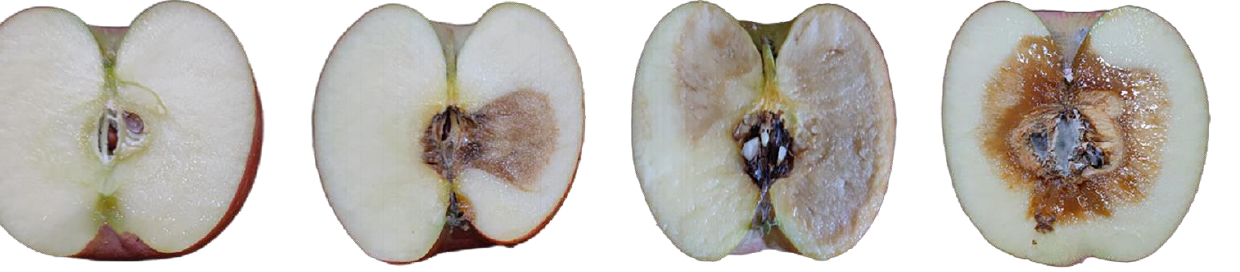
Figure 10. Varying degrees of moldy core in apple halves (the one on the far left is the healthy apple and the rest are diseased apples).